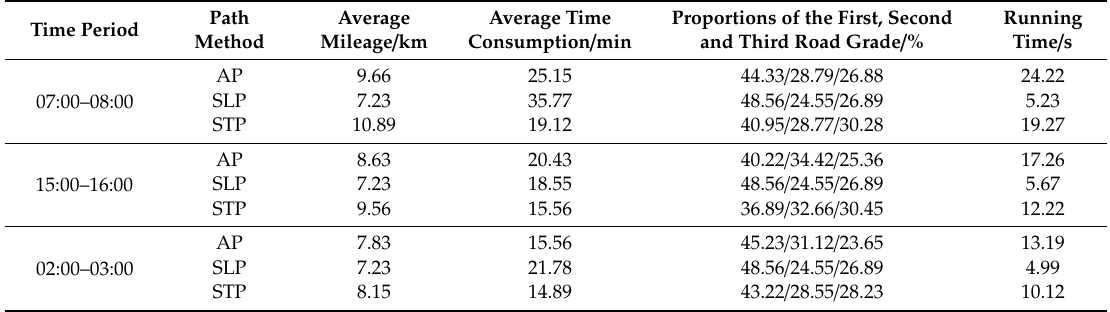
Table A4. Comparison of tra ffi c operation index of each path method under peak, flat hump and o ff -peak time periods.